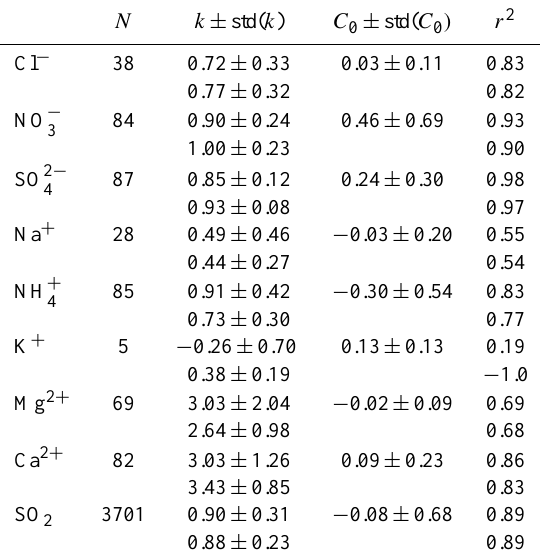
Table 3. Coefficients of the linear regressions of the concentrations measured with the MARGA data vs. those analyzed from the PM 10 filters and the SO 2 measured with a Horiba APSA 360 monitor: C (MARGA) = k · C (comparison method) + C 0 . N = number of ob- servations used in the regression. For explanation of the uncertain- ties of k and C 0 see Sect. 3.2. For K + the r 2 statistic is negative for the model without a constant, indicating that the model is not appropriate for the